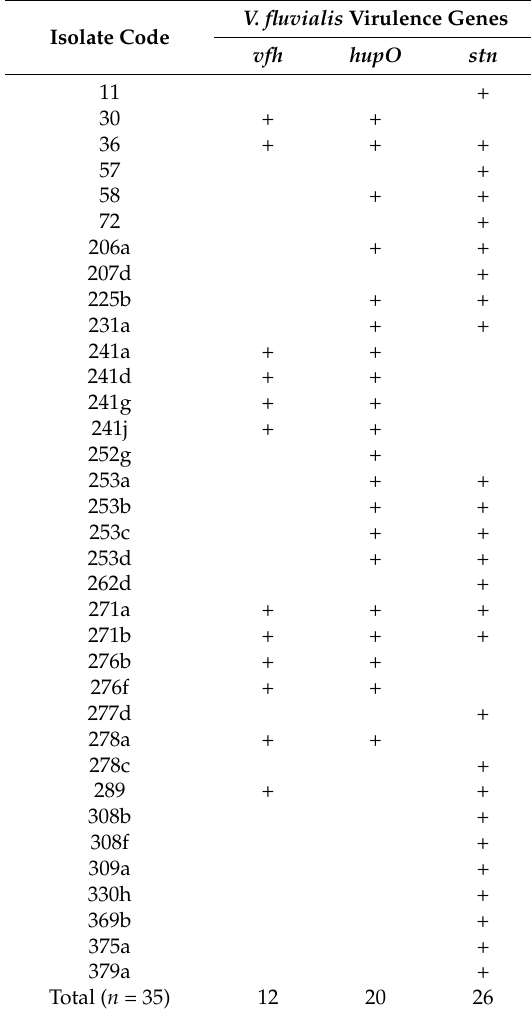
Table 5. Distribution of virulence genes in V. fluvialis